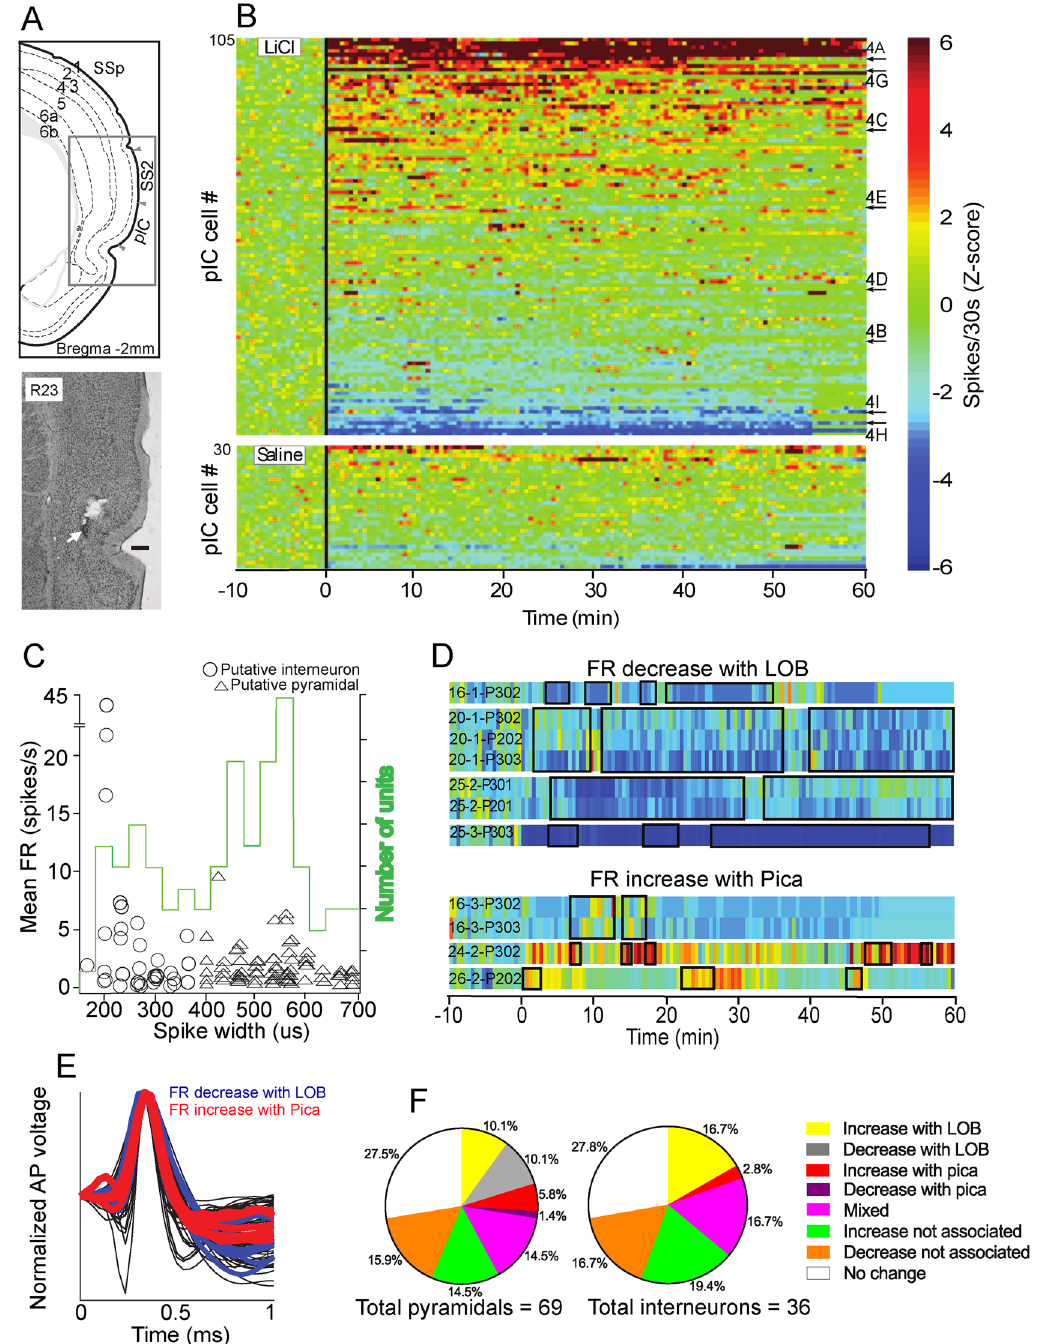
Figure 3. pIC neurons responded to LiCl injections and GI malaise. ( A ) Top panel depicts an anatomical drawing adapted from 47 . pIC, posterior insular cortex; SSs secondary somatosensory cortex. Bottom panel shows an electrolytic lesion (white arrow) in the pIC, 0.3 mm ventral (scale bar) to the recording site. ( B ) Top, colored PSTH for cells responsive to IP LiCl injection (at time 0). The arrows and letters denote the position in this plot of the units shown in Fig. 4. Bottom, subset of neurons showing responses to IP NaCl injection. The color codes represent the intensity of firing rate. ( C ) Scatter plot depicting the spike peak-to-trough duration and firing rate for all the pIC neurons. Pie charts show proportions of pIC cell types responding to LiCl injections and behaviors. ( D ) PSTH shows the changes in single putative pyramidal neurons activity during LOB (top) and Pica (bottom). Black rectangles on the PSTH represent LOB and Pica on the top and bottom chart respectively. The firing rate is depicted with the same color code as in ( B ). ( E ) Waveform of the same putative pyramidal neurons as in ( D ), whose activity was associated with LOB and Pica. ( F ) Pie charts showing the proportions of putative pyramidals and interneurons associated with LOB and